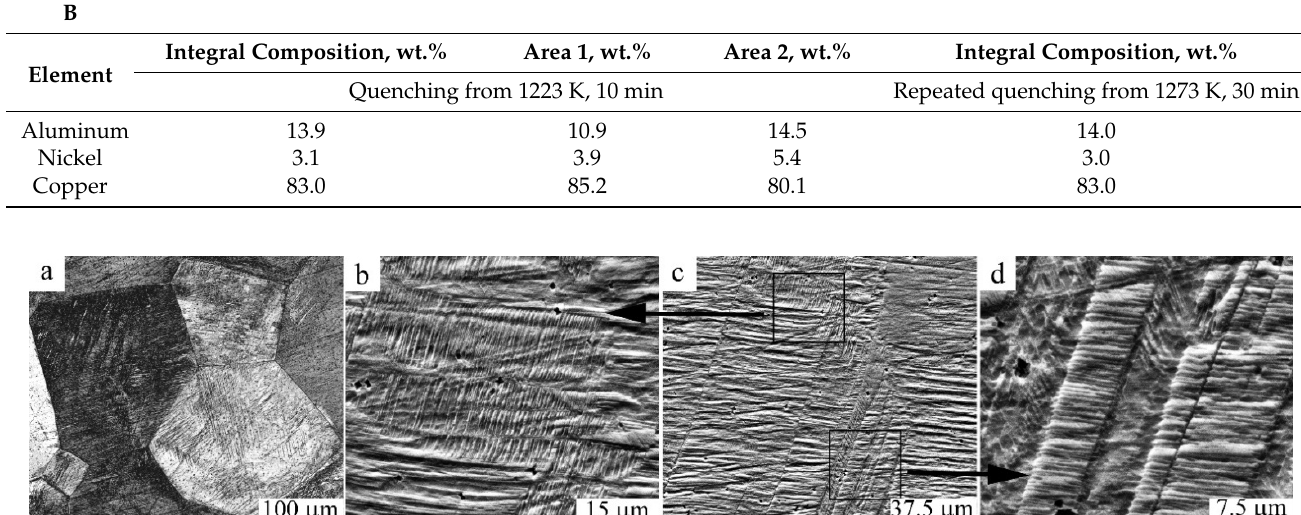
Figure 9. ( a ) OM image and ( b – d ) SEM images of the packet martensite microstructure of Cu-14Al-3Ni alloy after repeated quenching from 1273 K, 30 min. The arrows show the placement of enlarged fragments ( b , d ) [46]. As is known, β -austenite of alloys at temperatures higher than T ED and M s have the time management to experience two consecutive phase transitions «disorder–order» ( β → β 2 (B2) → β 1 (D0 3 )) [3,44]. As a result of the multi-type nucleation mechanism, a special substructure of anti-phase (AP) domains is formed, the boundaries of which (APB) are clearly visible on dark-field TEM images in superstructural reflections (Figure 11). The long- range atomic order of the initial austenitic phase is inherited by the structure of martensite, determining its important role in the realization of the effects of orientational crystal- structural reversibility and phase thermoelasticity at a TMT [3–5]. APBs had predominant crystallographic faceting along the planes of {100} and {110} of cuboid domains (Figure 11). During the TEM study, tweed striped diffraction contrast was also observed in the light- and dark-field austenite images (Figure 11). As the analysis has shown, the tweedy pattern is oriented along various crystallographic directions, which are mainly intersections of the planes {110} with the foil surface [52]. This tweedy pattern (TP) has a fine structure formed by equiaxial and cubic elements of homogeneous contrast alternating according to the type of quasi-periodic 3D-modulated FCC structure. At the TP background, one can see a contrast from the dislocations and APBs shown above. At the same time, the contrast and dimensions of the tweed elements on the APBs shown above indicate their preferred heterogeneous localization along these coherent superstructural boundaries of subgrains. A similar increase in tweed contrast was also noted in images of dislocations, both belonging to the inclined and horizontally disposed planes